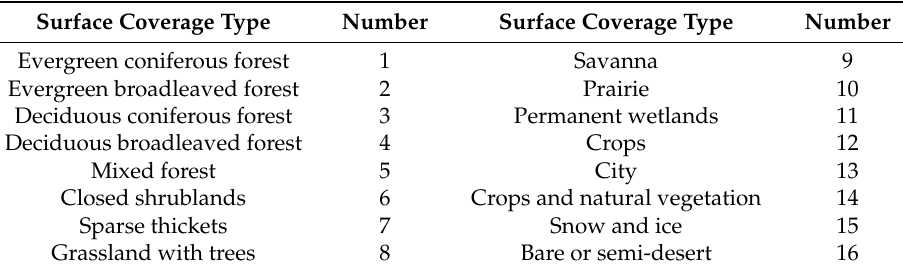
Figure 3. IGBP land cover classification map. Table 2. Codes for land cover types included in the IGBP map.